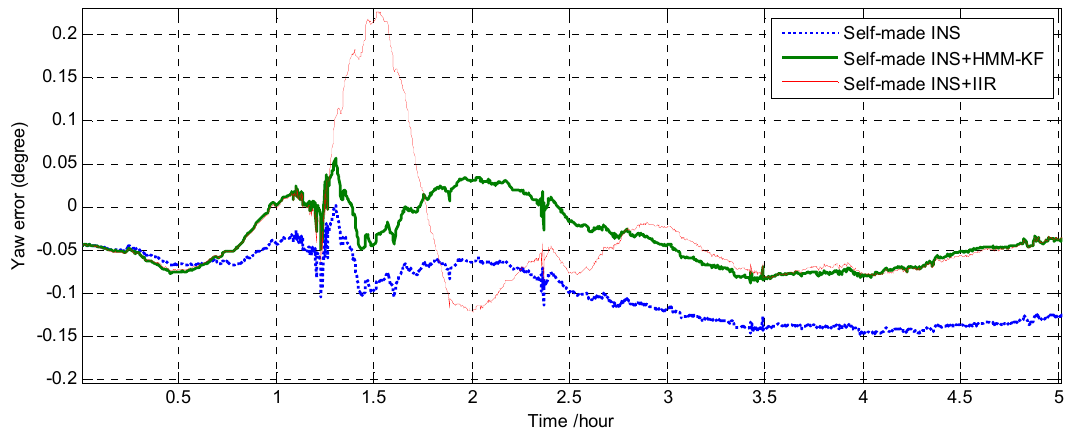
Figure 18. Comparison of the yaw (heading) error using the three schemes.